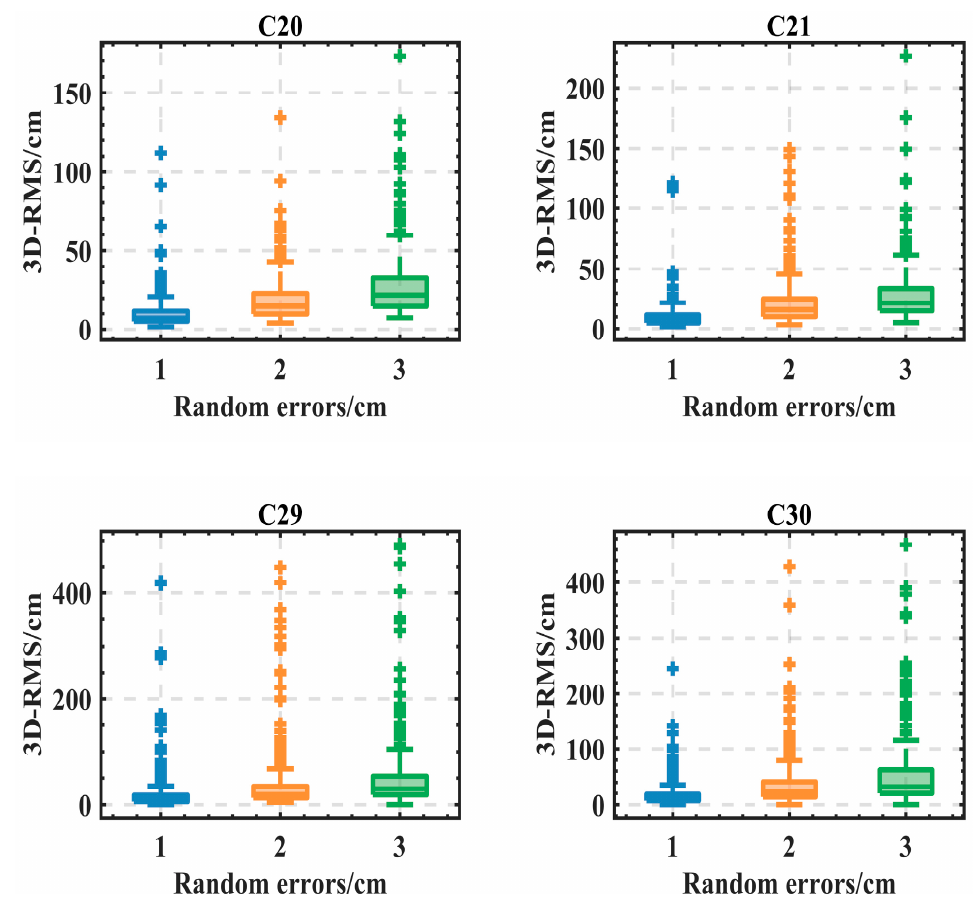
Figure 10. BDS-3 satellites simulated POD accuracy (with random errors).